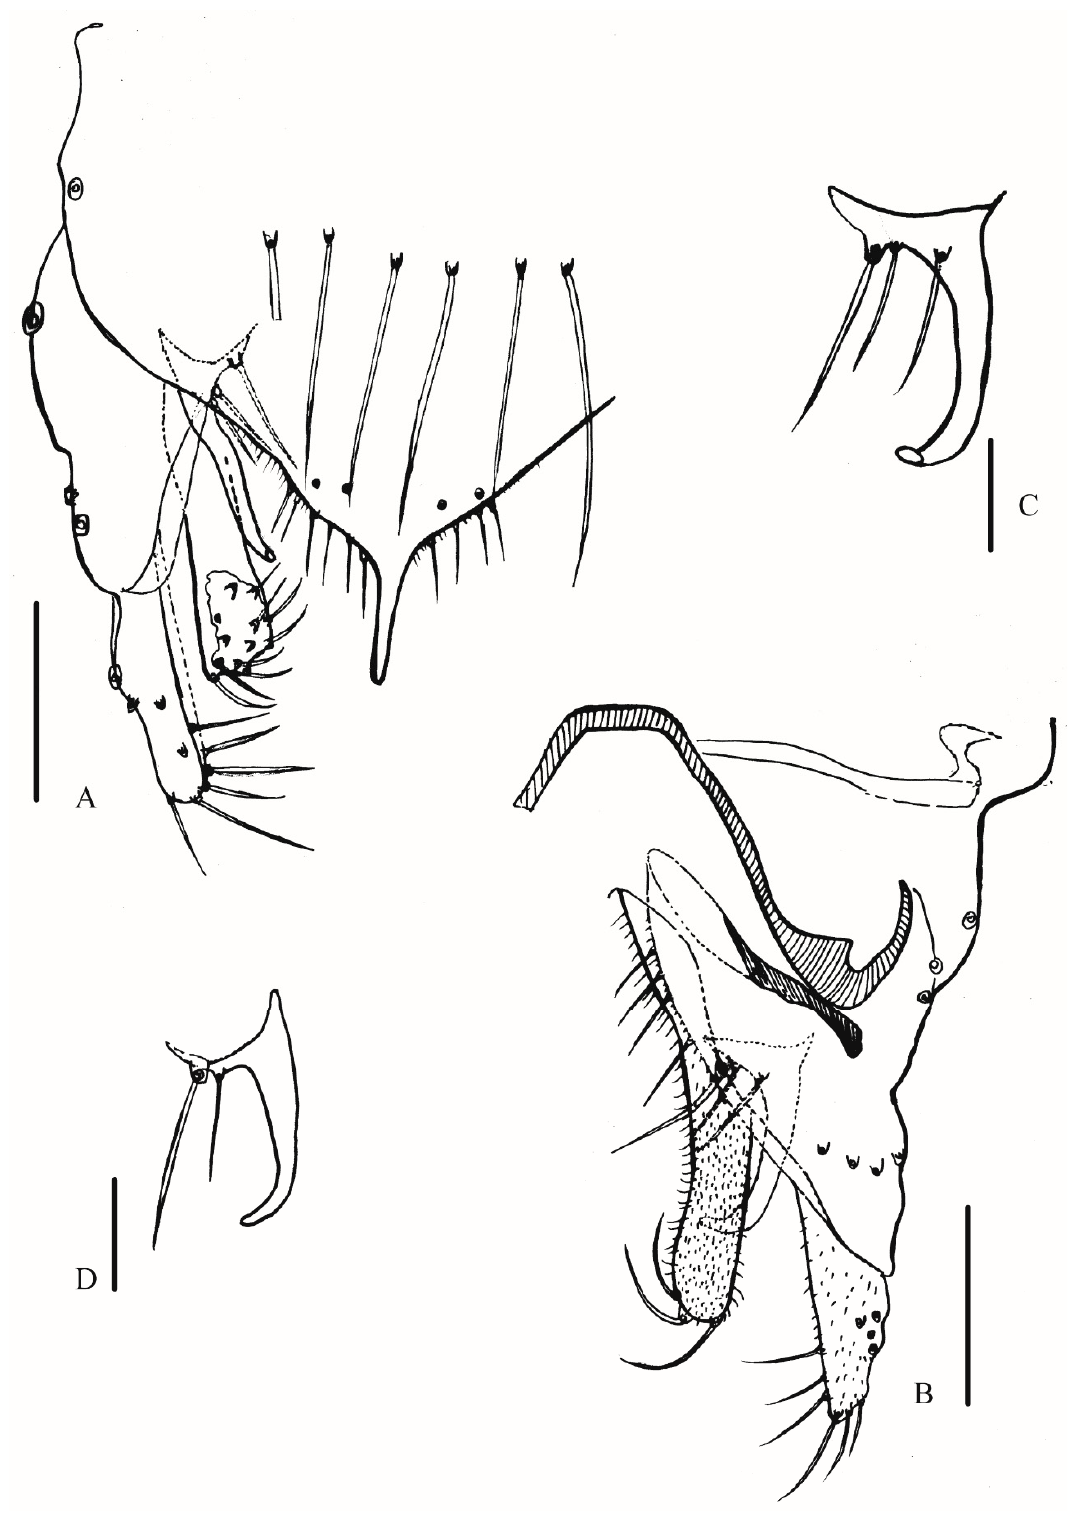
Figure 6. Y. balteatus sp. n. , male. Illustration: ( A ) hypopygium, dorsal view; ( B ) hypopygium, ventral view; ( C , D ) superior volsella. Scale bar: A–D, 100 µm.